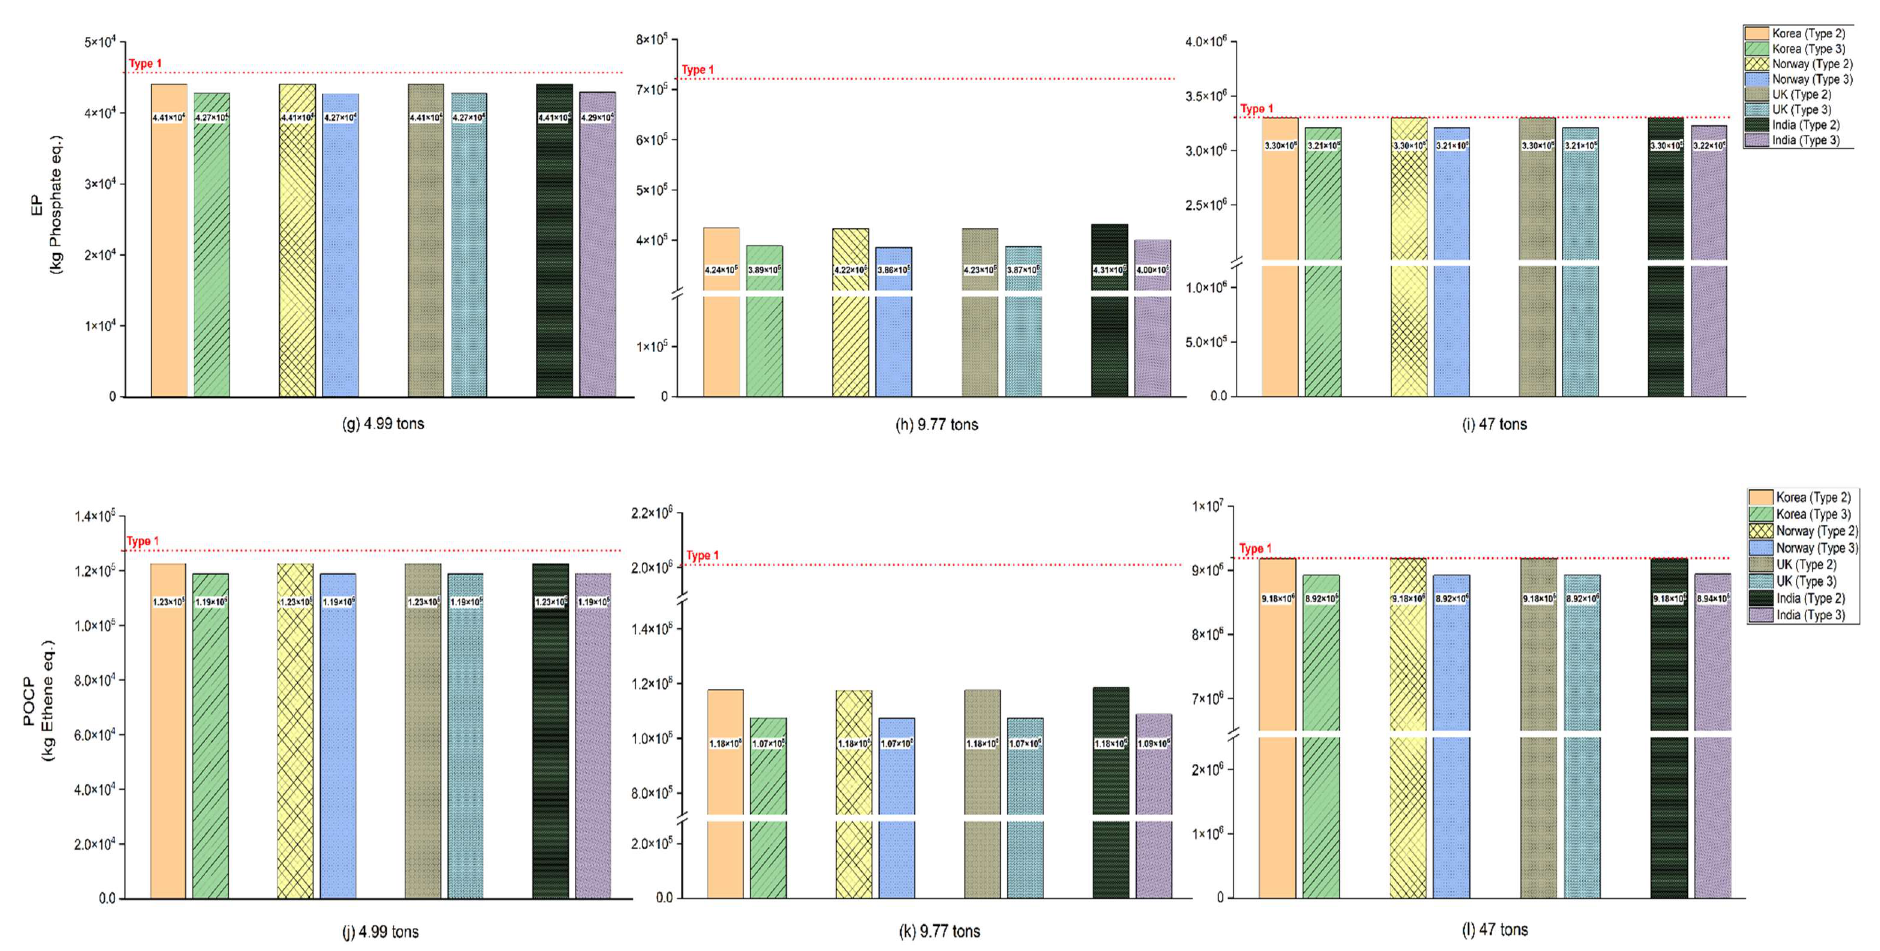
Figure 14. Environmental impacts during the lifespan of each ship using electricity produced in four different countries.